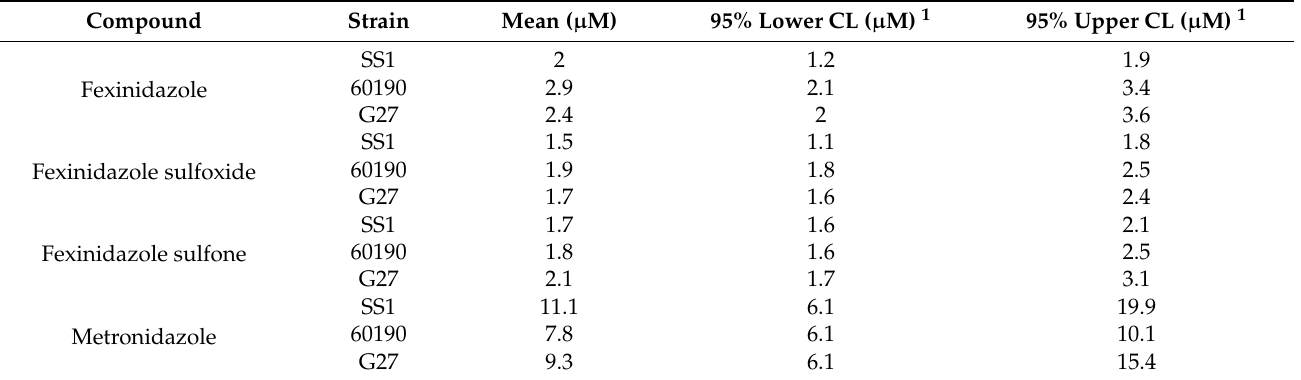
Figure 5. Concentration-dependent inhibition of growth of H. pylori by fexinidazole sulfone. Strains SS1 ( A ), 60190 ( B ), and G27 ( C ) were treated with different concentrations of fexinidazole sulfone for 24 h and EC 50 curves were generated from mean values of percentage growth inhibition ± SEM of fexinidazole sulfone against H. pylori . Table 1. EC 50 values of fexinidazole, fexinidazole sulfoxide, fexinidazole sulfone, and metronidazole against H. pylori .